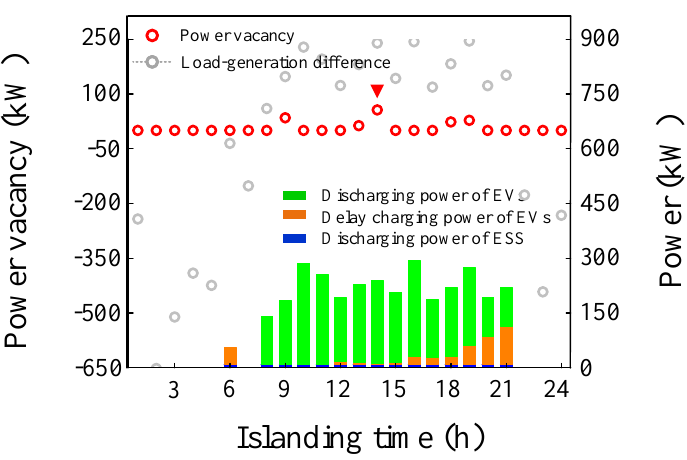
Figure 6. Connected operation with deployed DGs and ESS.